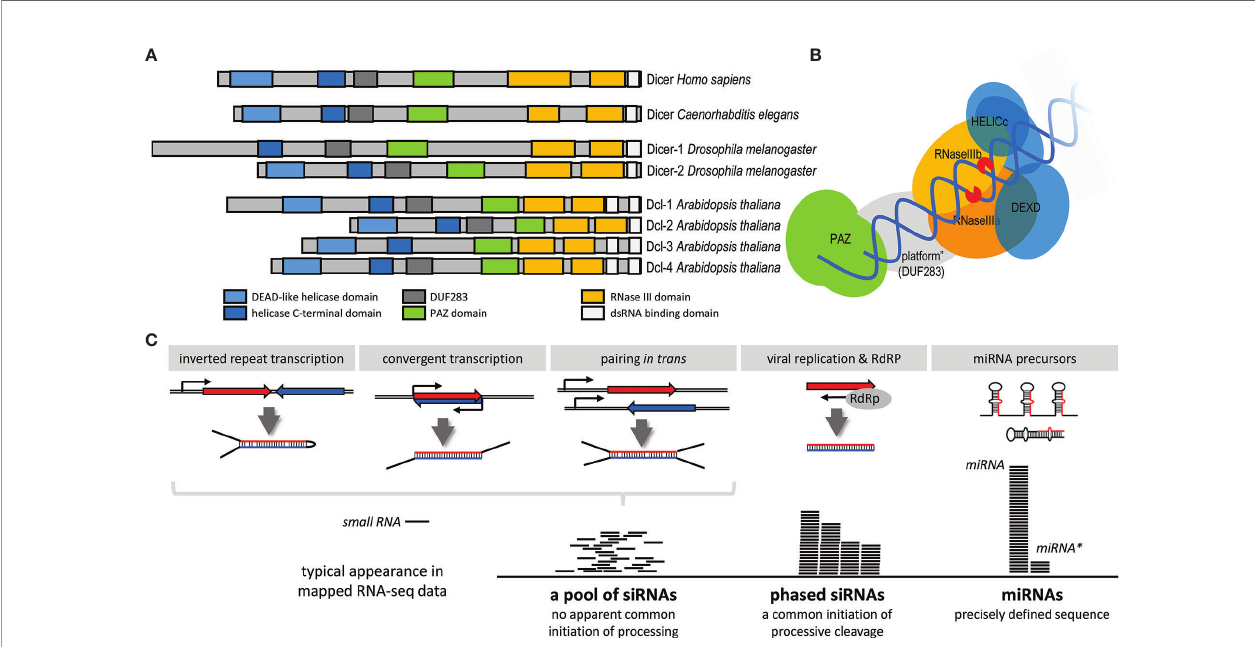
FIGURE 3 | Dicer and production of small RNAs. (A) Domain composition of Dicer proteins in a common multicellular model system. (B) Schematic organization of Dicer and its interaction with dsRNA [based on the mammalian Dicer structure (Lau et al., 2012)]. (C) Model examples of different types of Dicer substrates and products. Production of phased small interfering RNAs (siRNAs) requires a double-stranded (dsRNA) terminus where Dicer will initiate processive cleavage. It could be produced by an RdRP, typically during viral replication. In speci fi c cases, such as plant phased siRNAs (phasiRNA), also by a cellular RdRp [reviewed in (Komiya, 2017)]. However, not all RdRP-produced dsRNAs result in the formation of phased